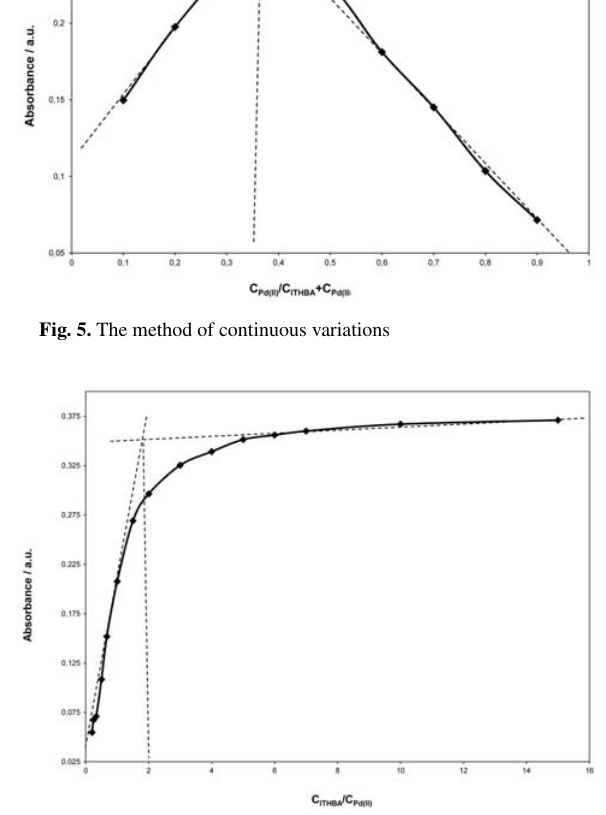
Fig. 6. The mole-ratio method